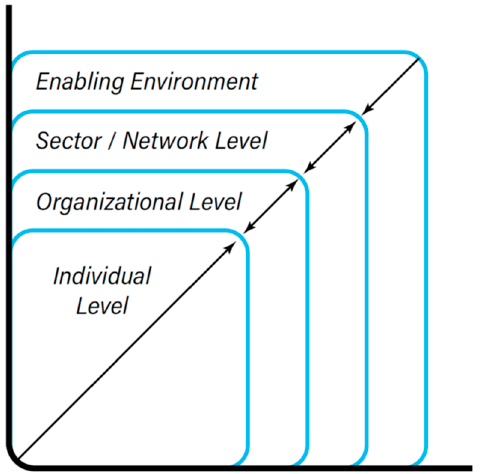
Figure 5. Conceptual framework for capacity development. Source: [34].